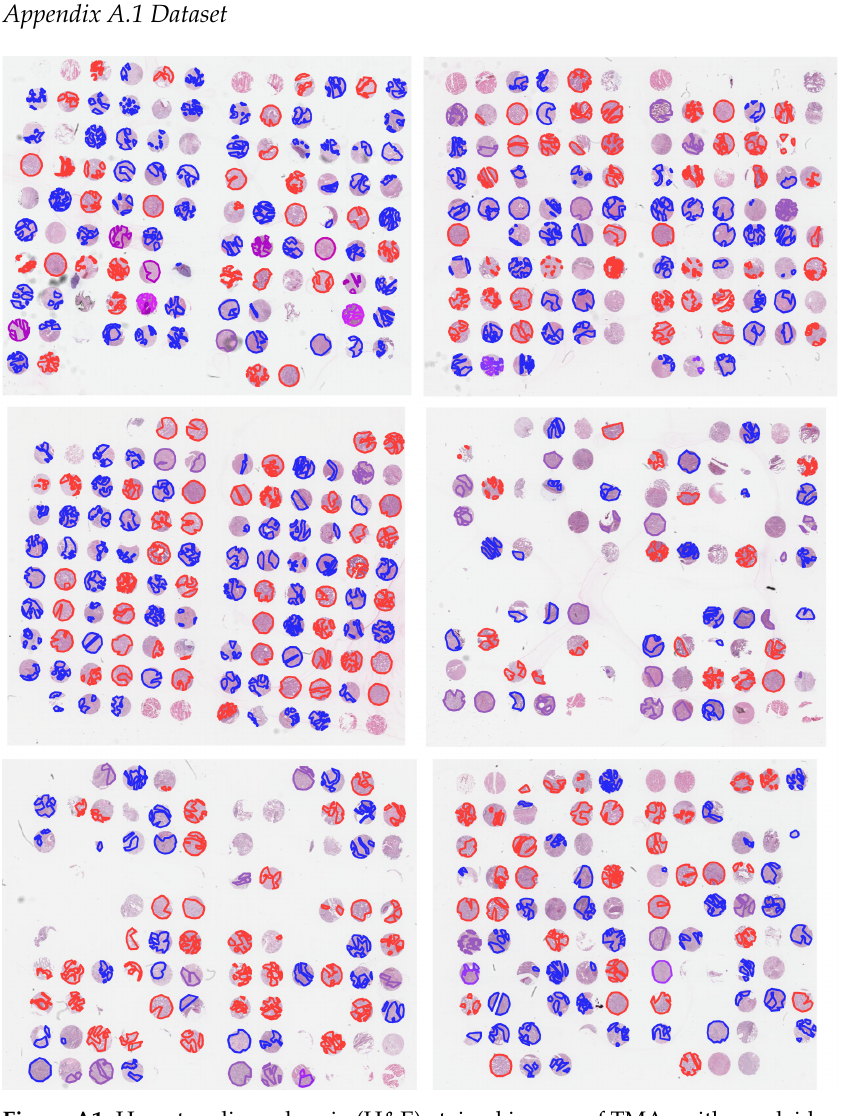
Figure A1. Hematoxylin and eosin (H&E)-stained images of TMAs with overlaid annotations (red lines: ADC, blue lines: SqCC, purple lines: other tumor types). Image was previously published in the work of Janßen et al.